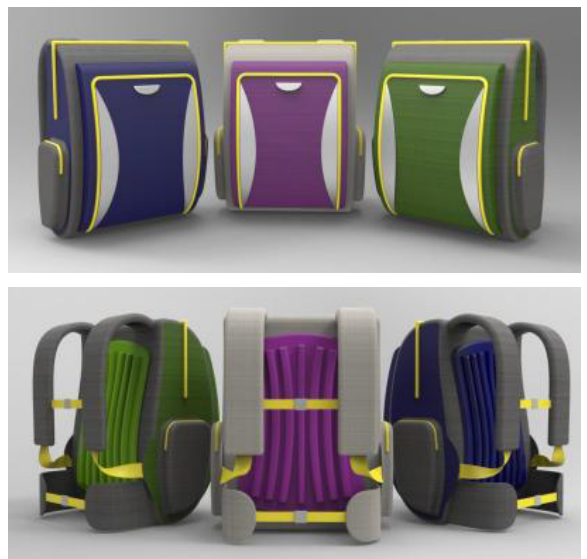
Figure 13. 3D models of the backpack showing a variety of colour combinations